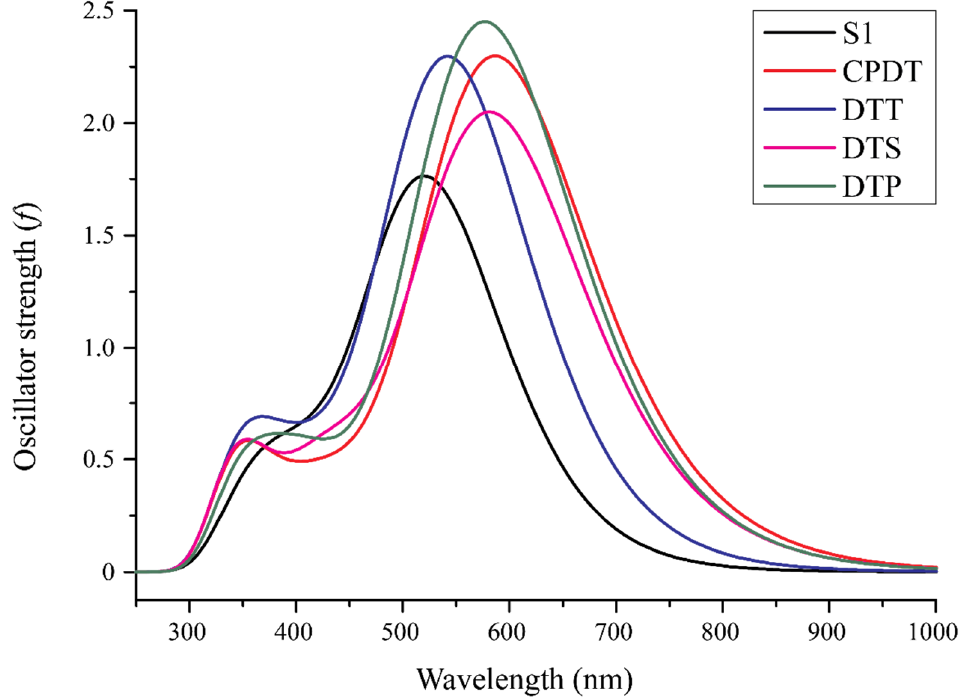
Figure 3. Simulated UV-Vis absorption spectrum in chlorobenzene solvent of the compounds considered (TD-DFT / B3LYP / 6 − 311G (d, p)).